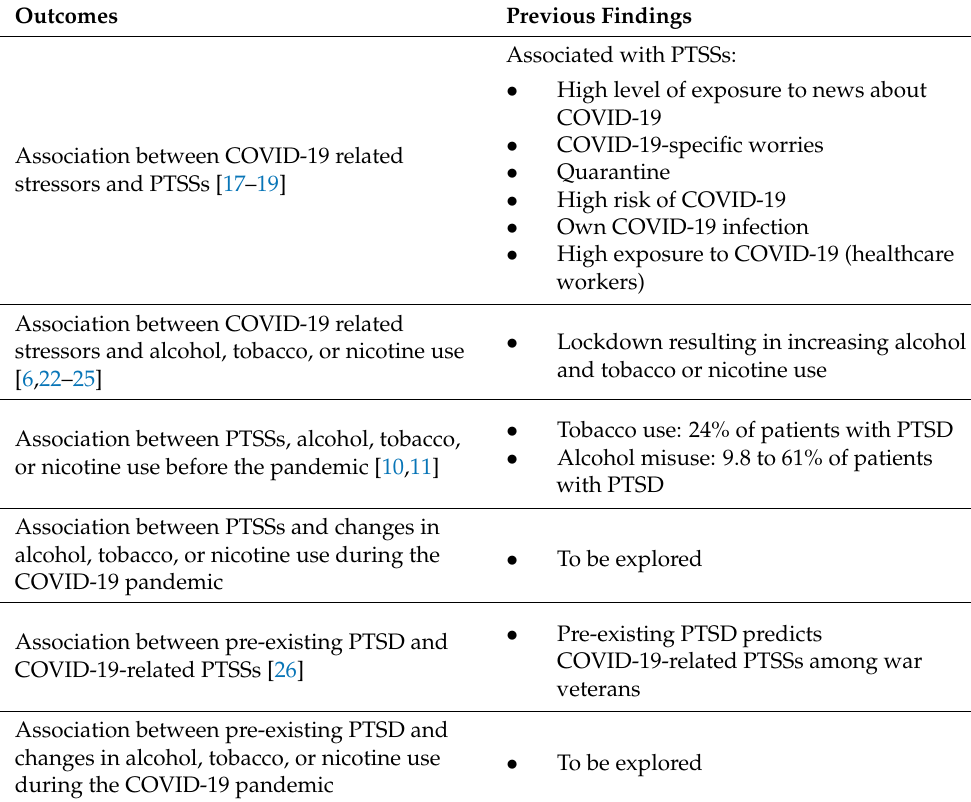
Table 1. Previous findings concerning PTSSs, alcohol, tobacco and nicotine consumption, and COVID-related